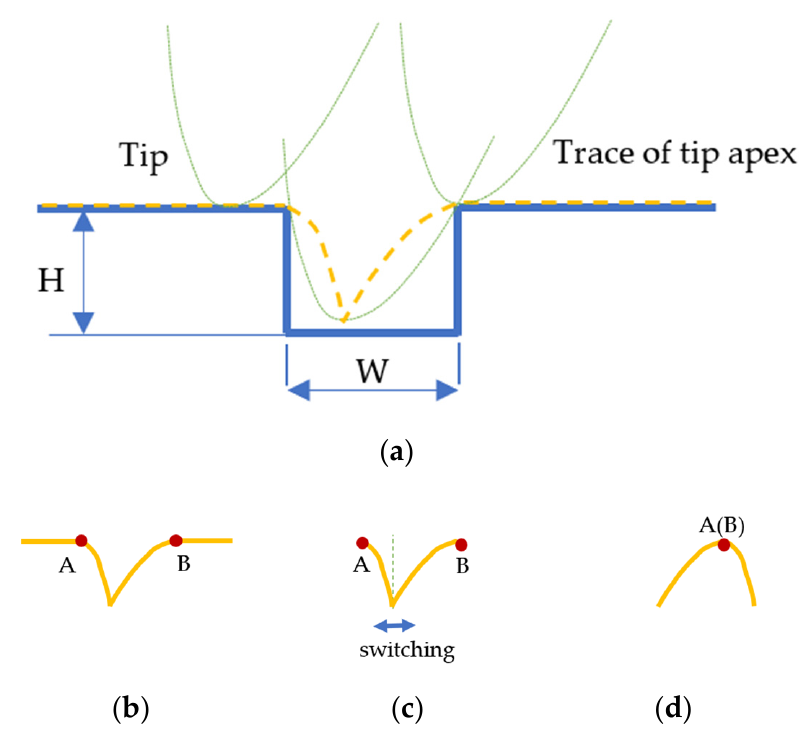
Figure 5. Tip characterization using a rectangular groove feature. ( a ) The measured profile of the rectangular groove feature; ( b ) determining ridge edges A and B; ( c ) selecting the segment between A and B from the measured profile and switching the segment parts on either side of the line perpendicular to the lowest point; ( d ) overlapping edges A and B and reconstructing the tip geometry.